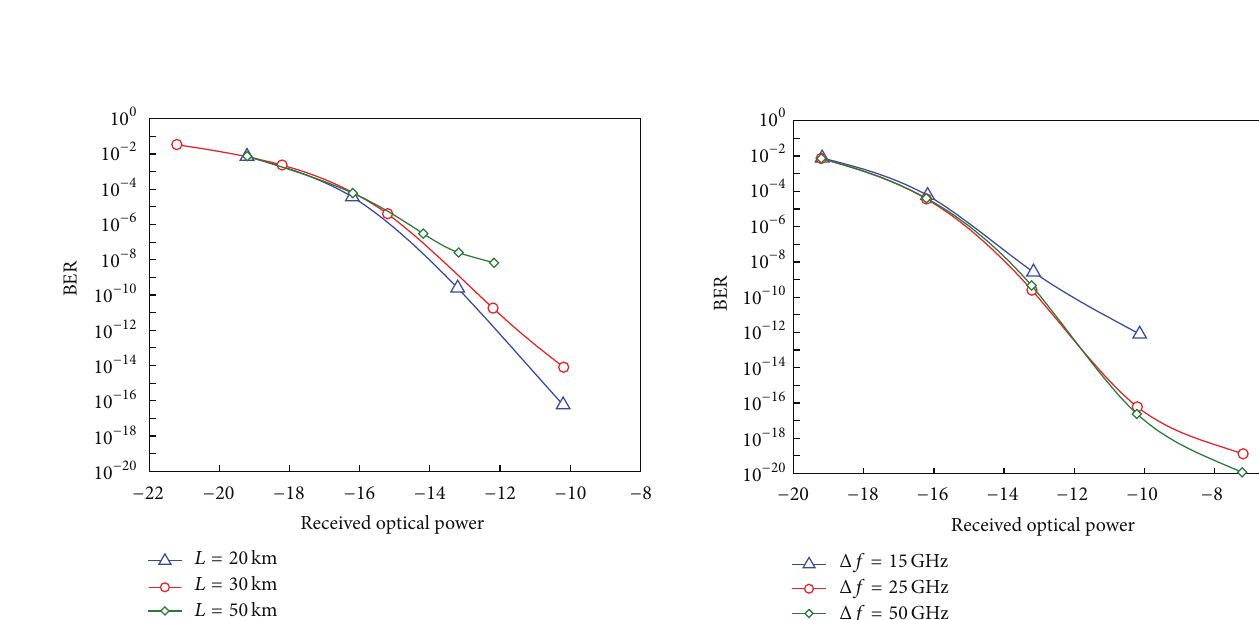
Figure 6: The BER performance versus received optical power at the carrier frequencies: (a) 2.4 GHz and (b) 5 GHz.